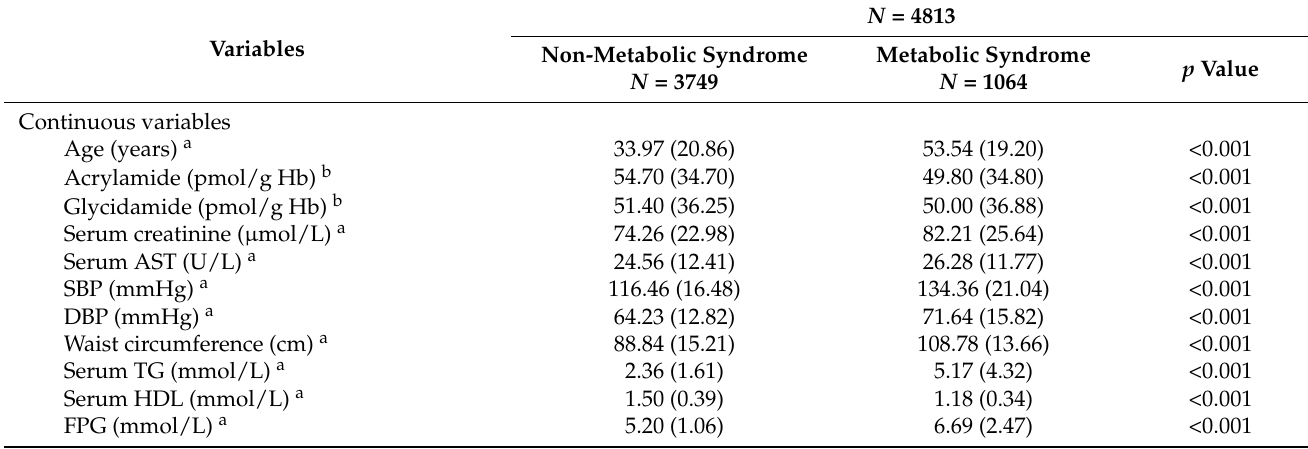
Table 2. Characteristics of participants with and without metabolic